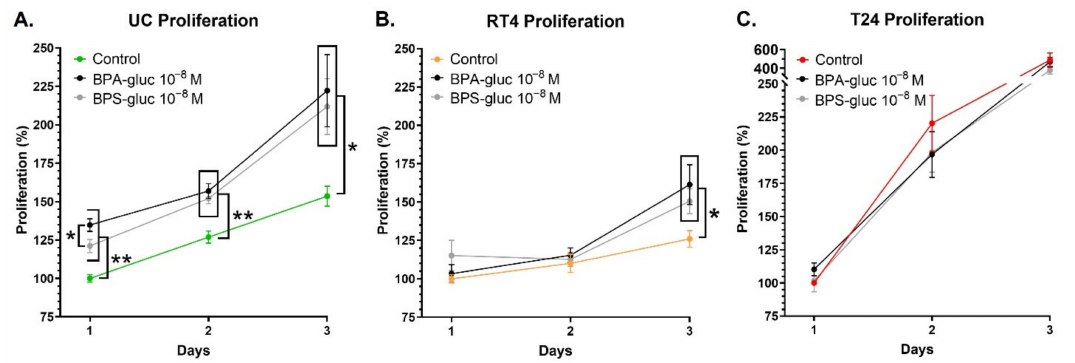
Figure 5. Chronic exposure to physiological concentrations of glucuronidated BPA and BPS increases the proliferation rate of UCs and RT4 non-invasive bladder cancer cells. The proliferation rate of ( A ) normal urothelial cells (UCs), ( B ) RT4 non-invasive bladder cancer cells, and ( C ) T24 invasive bladder cancer cells was established over three days, with or without chronic exposure to physiological concentrations of BPA-gluc or BPS-gluc. The proliferation rate is illustrated by the number of cells as a function of time. Data, presented as the mean ± SEM, are displayed as percentages of controls at day 1 (i.e., untreated condition) (n = 3, N = 3). * p < 0.05, ** p < 0.01 by Mann–Whitney